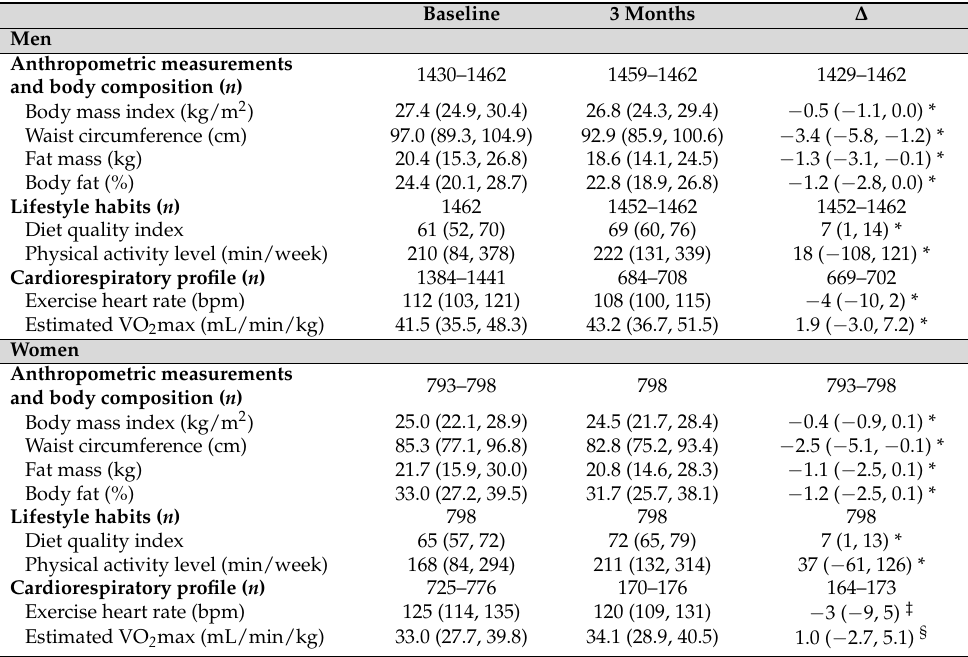
Table 2. Employees’ characteristics as well as markers of lifestyle habits before and after the 3-month lifestyle modification program.